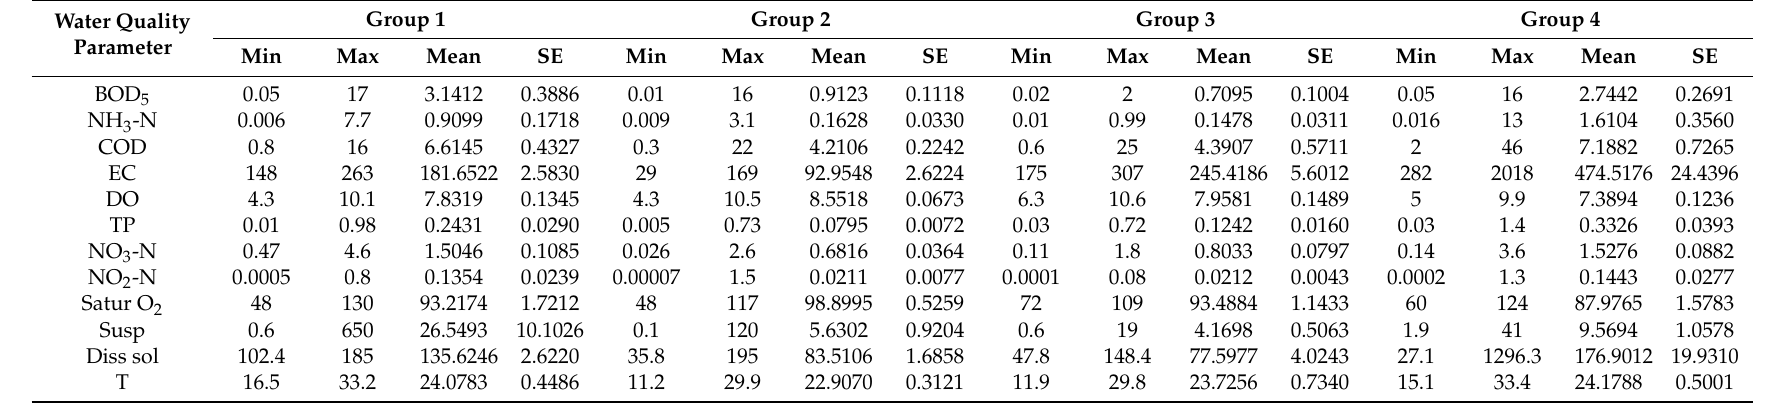
Table 7. Statistical description of each